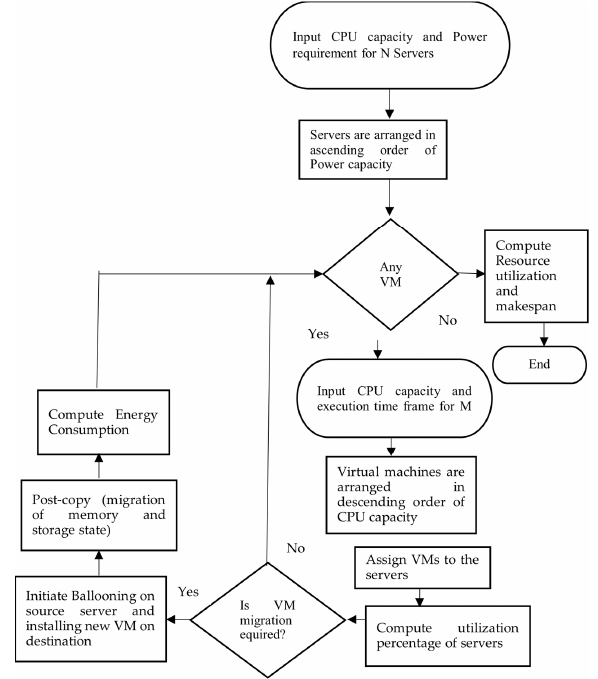
Figure 9. Overall workflow of cloud data center.